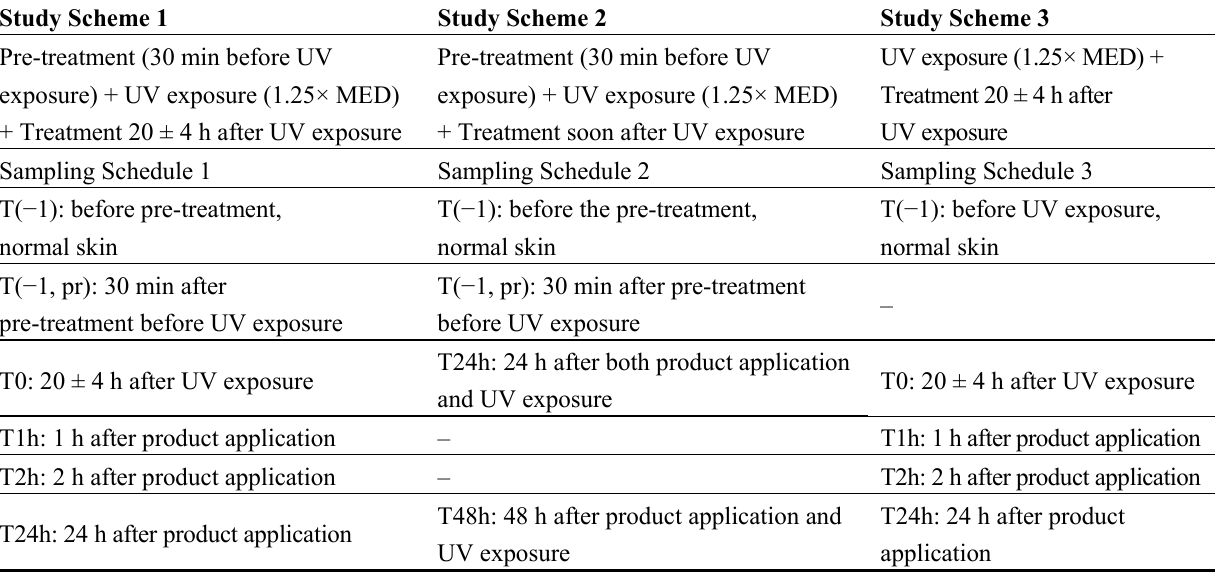
Table 2. Study schemes and sampling schedules for clinical protection and